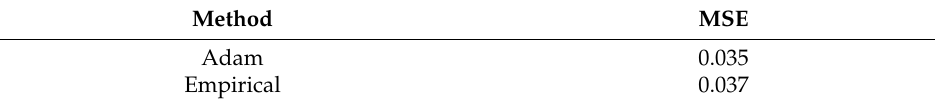
Figure 8. Error under the two methods. Table 2. MSE under the two